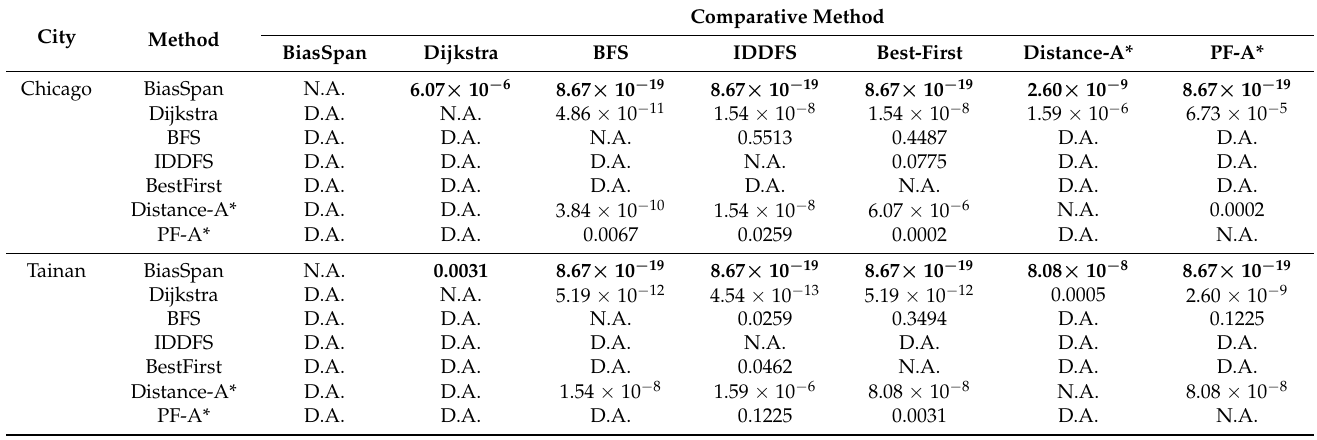
Table 12. p -Values in Wilcoxon signed-rank test for all pairs of methods towards unit PF performance. Where “N.A.” refers to incompatibility since the algorithm cannot be compared to itself; and “D.A.” refers to the disadvantage where the targeted method has more negative ranks than positive ranks when been analyzed with the comparative